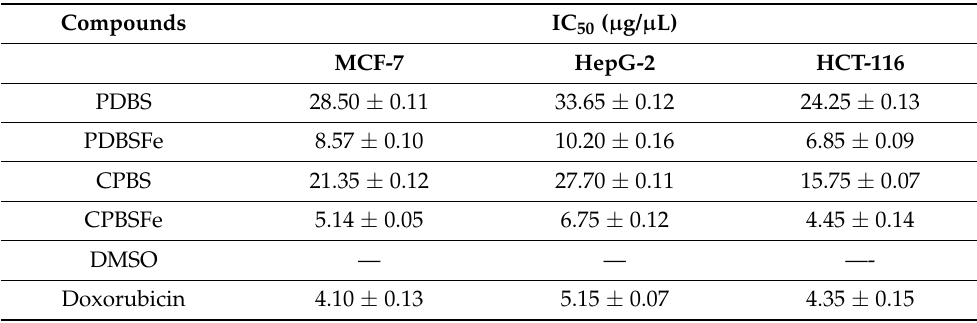
Table 7. Cytotoxic activity (IC50) of the prepared compounds against HCT-116, HepG-2, and MCF-7 cell